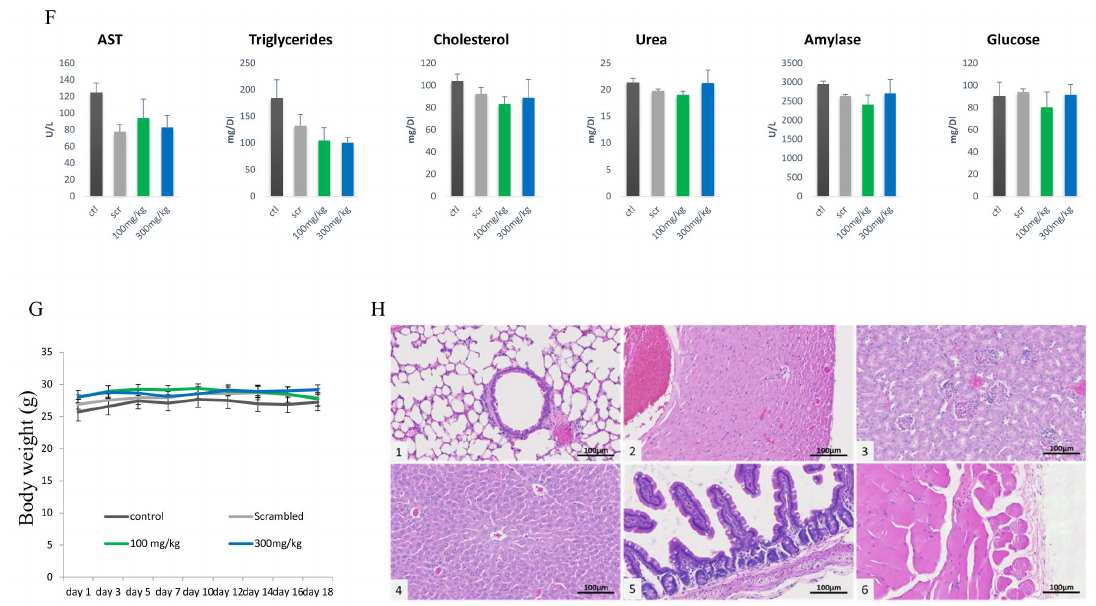
Figure 5. TP5 crosses the blood–brain barrier in vivo, suppresses GBM tumor growth in vivo and shows no systemic toxicity. ( A ) Tumor volume over time is shown for the 4 groups (Control N = 4; Scrambled N = 3; TP5 100 mg/kg N = 4; TP5 300 mg/kg N = 4). ( B ) Representative bioluminescent images of control and TP5 (100 mg/kg) groups on day 0 (first day of treatment), day 8 and day 18 (last day of experiment). ( C ) Tumor volume (luminescence signal) over time is shown for each group: control and scrambled peptide (left panel); control and TP5 at 100 mg/kg (middle panel); control and TP5 at 300 mg/kg (right panel). ( D ) TPF5 signal (green) in the xenograft intra-cranial tumor area is shown. ( E ) Blood hematologic count of neutrophils, lymphocytes, hemoglobin and platelets at day 18 of treatment is shown in the four groups (ctl: control N = 4; scr: scrambled N = 3; TP5 at 100 mg/kg N = 4 and 300 mg/kg N = 4). No significant difference was observed. ( F ) Blood concentration of AST, triglycerides, cholesterol, urea, amylase and glucose at day 18 of treatment is shown in the four groups (ctl: control N = 4; scr: scrambled N = 3; TP5 at 100 mg/kg N = 4 and 300 mg/kg N = 4). No significant difference was observed. ( G ) Mouse weight over time is shown from the first day of treatment until the end of experiment (day 18). ( H ) Pathological examination of mouse organs is shown: 1- lung; 2- heart; 3-kidney; 4- liver; 5-colon; 6-peritoneum.